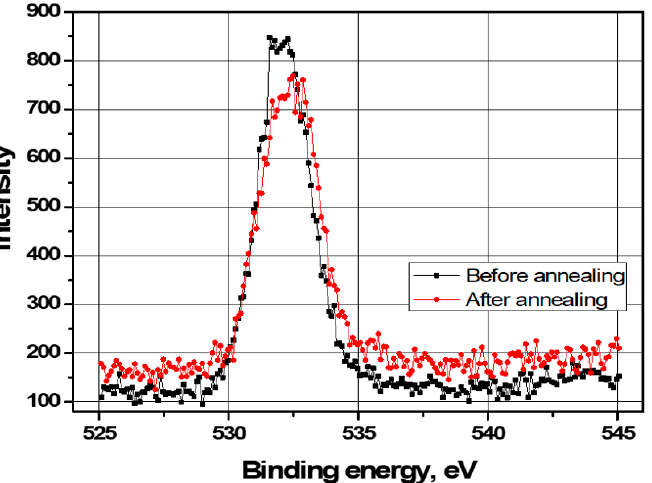
Figure 5. O 1s XPS spectra associated with Ga oxide on the AlGaN surface of the MSM AlGaN UV sensor before and after selective annealing.